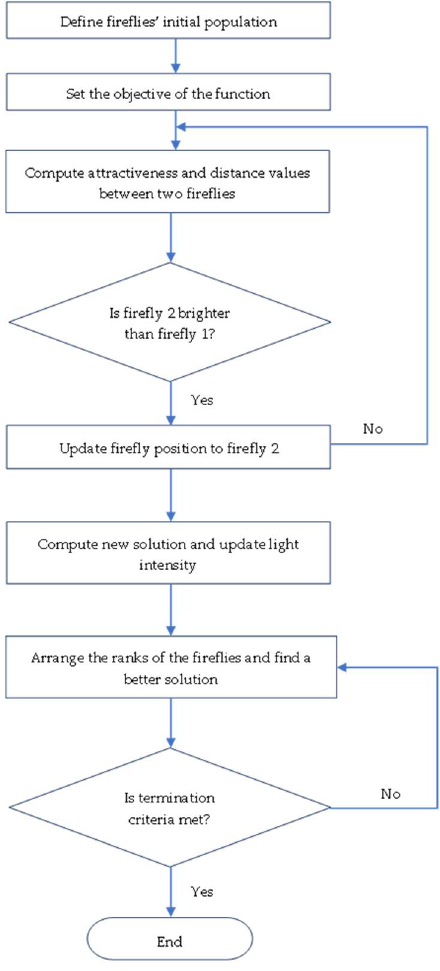
Figure 3. Firefly algorithm flowchart.